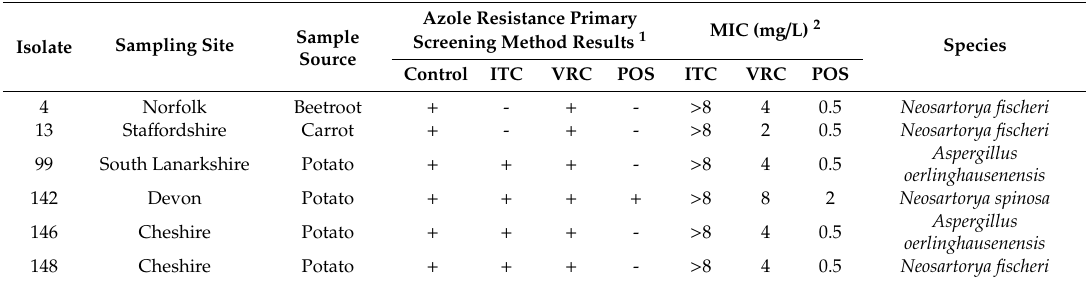
Table 2. Characteristics of the azole-resistant fungal isolates identified in this